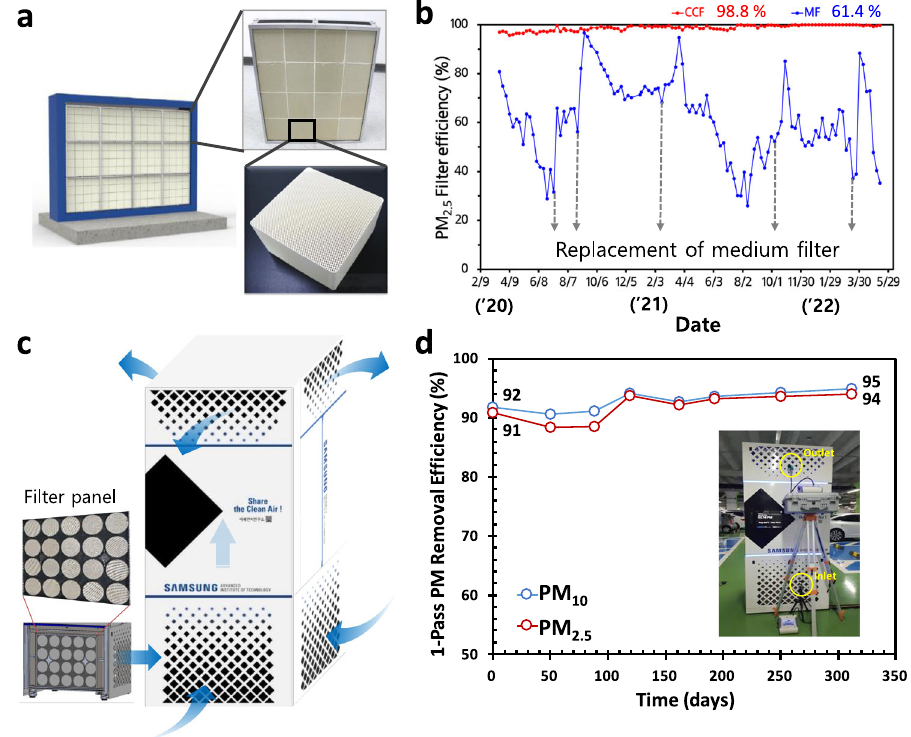
Fig.6|CFapplicationsforsharingthecleanair.a CFpanelsysteminstalledatthe HVAC facility of the building. b PM 2.5 FE of CF and MF measured for 30 months in the building. c Free-standing proto-type CF system. d FE of PM 10 and PM 2.5 of